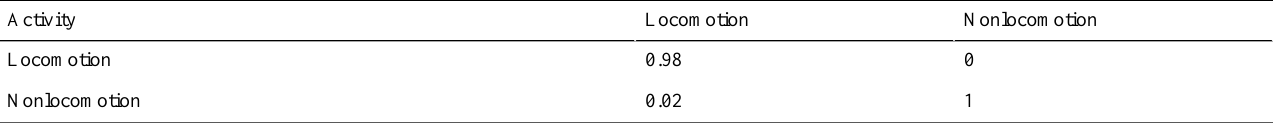
Table 7. Normalized confusion matrix showing the percentage of correctly classified instances for the random forest model used for activity type classification tasks based on locomotion. Each column shows the actual activity and rows represent the predicted labels.